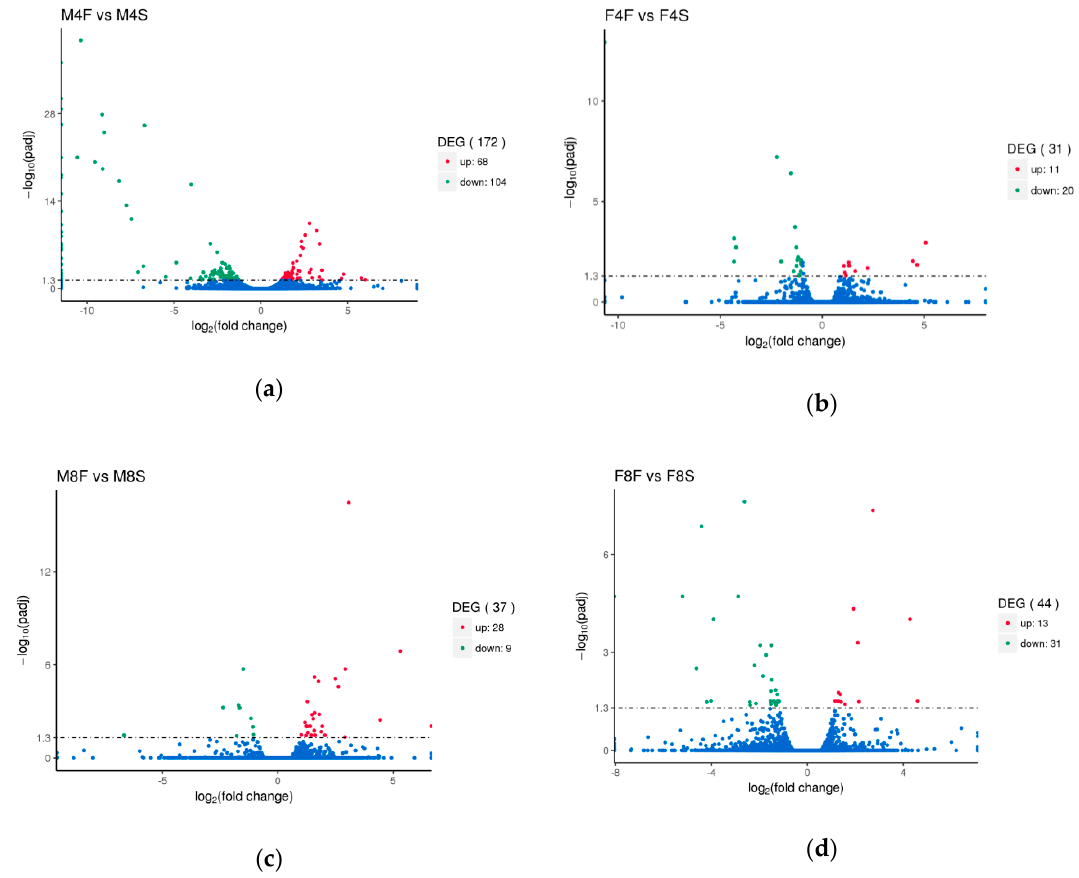
Figure 1. Volcano maps of di ff erentially expressed genes. ( a ) Volcano map of di ff erentially expressed genes for four-week-old males. ( b ) Volcano map of di ff erentially expressed genes for four-week-old females. ( c ) Volcano map of di ff erentially expressed genes for eight-week-old males. ( d ) Volcano map of di ff erentially expressed genes for eight-week-old females.